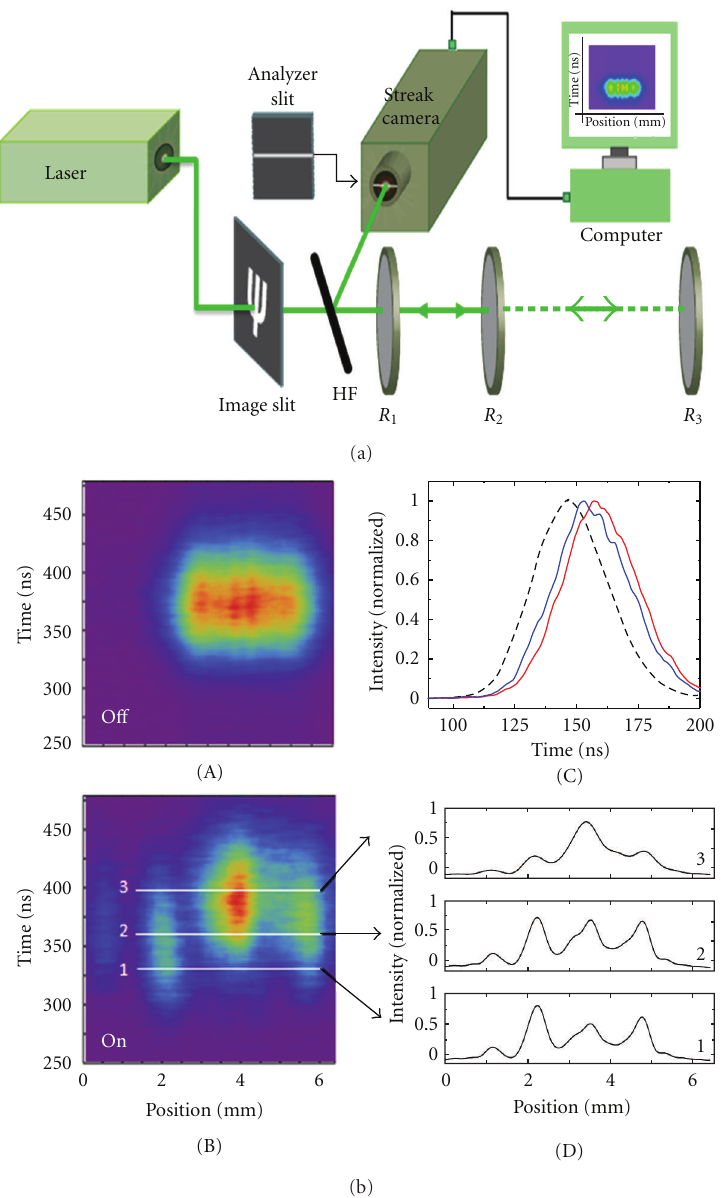
Figure 6: (a) Experimental setup for time- and space-resolved image propagation through the image resonator. Light pulses of 40 ns duration passed through an image mask and an image resonator system. The reflected images were sent to the streak camera using a half mirror (HF) to analyze time- and space-resolved reflected images. (b) (A) and (b) (B) show the reflected image for the o ff -resonance and on-resonance conditions, respectively. (b) (C) is the experimental observation of the temporal profiles of the reflected image. The dashed black curve is at the center of the o ff -resonance image; the solid blue and red curves are at the edge region and center region of the on-resonance image, respectively. (b) (D) is the cross-sectional profile of image (b) (B). The notations 1, 2, and 3 indicate the earlier, intermediate, and later times of the image,